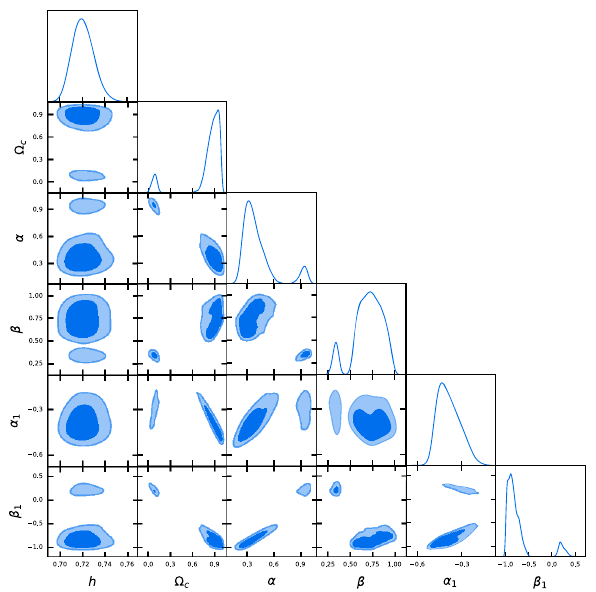
Fig. 4 ContourplotsformodelIMHRDE4withthe1 σ and2 σ